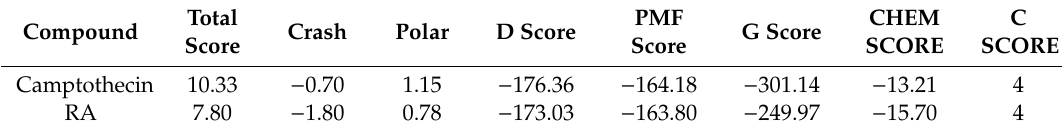
Table 3. The scoring function of ligands and DNA-Topo